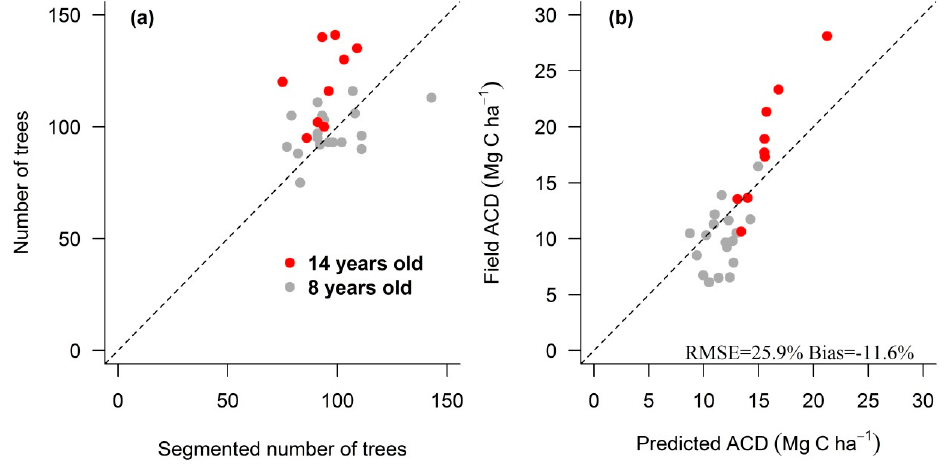
Figure 8. Relationship between ( a ) the number of trees in the 1-ha plots estimated from Pléiades optical imagery and number of trees obtained from the LiDAR-derived individual tree crown (ITC) segmentation approach, and ( b ) aboveground carbon density predicted from the ITC approach and ACD estimated from field data for 8-year-old and 14-year-old plantations. The 1:1 line is given for reference in both panels (dashed black lines).